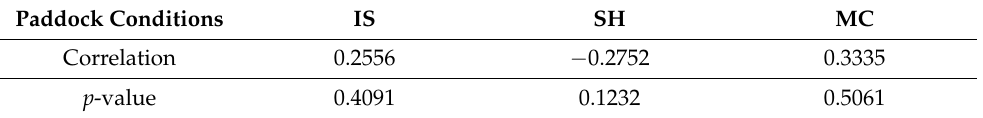
Table 2. Spearman rank correlation between rectal temperature after the test ( ◦ C) and time spent by the horses in different paddock areas during 2700 s of the test. Correlations are not significant ( p > 0.05). Paddock Conditions IS SH MC Correlation 0.2556 − 0.2752 0.3335 p -value 0.4091 0.1232